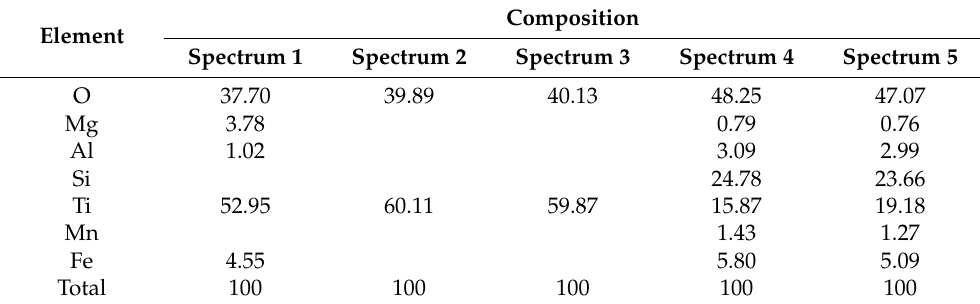
Figure 3. Microstructure of a laboratory slag Sample 8. ( a ) The figure shows the enlarged section of the slag sample at 4000× magnification. The term ‘Psb’ indicates the M 3 O 5 (pseudo-brookite) phase, ‘S’ indicates silicates and ‘Rt’ indicates rutile phase. ( b ) SEM-EDS of the slag sample showing the areas of spectrum analysis. Table 4. SEM-EDS analysis of the slag Sample 8 showing the elemental composition of various phases in the slag. The corresponding spectrum points can be observed in Figure 3b.